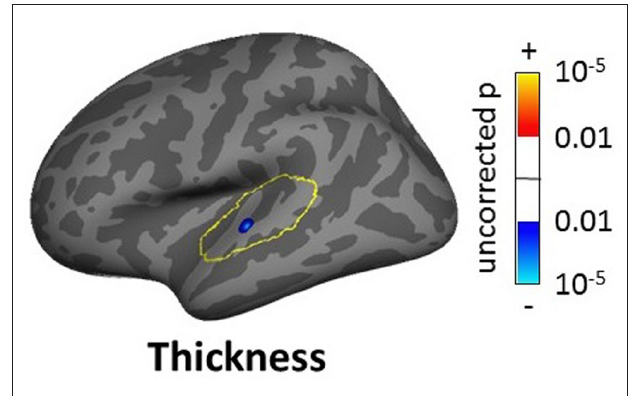
FIGURE 9 | Cluster showing a significant effect ( p < 0.05 FWE-corrected) of tinnitus in left AC in the masked SBM analysis for the severe tinnitus grouping. The yellow outlines depict the AC masks used to restrict the vertexwise analysis. The blue area corresponds to a negative effect (decrease in thickness for the severe tinnitus group vs. matched